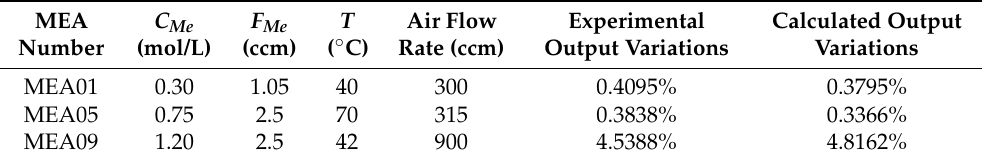
Table 8. Data of model robustness analyses.